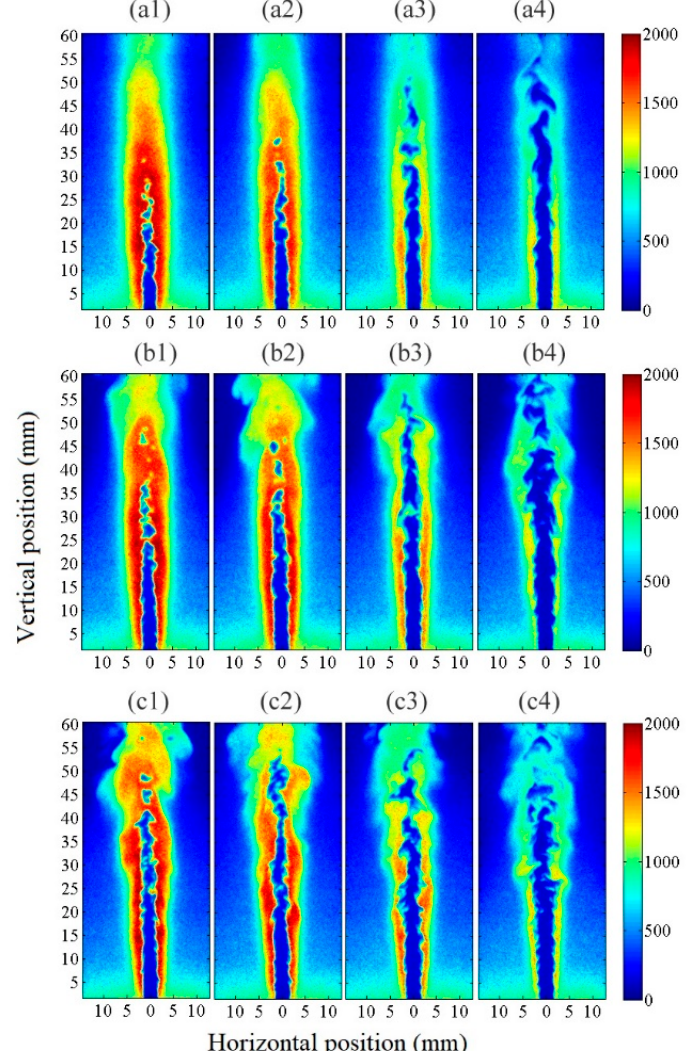
Figure 6. OH distribution instantaneous image of syngas with volumetric ratio of 25%H 2 –75%CO under different dilutions and Reynolds numbers: ( a1 – a4 ) Re = 6110; ( b1 – b4 ) Re = 10,690; ( c1 – c4 ) Re = 15,270. 1,2,3, and 4 indicate nitrogen dilution volumetric proportions of 0%, 10%, 30%, and 50%, respectively.